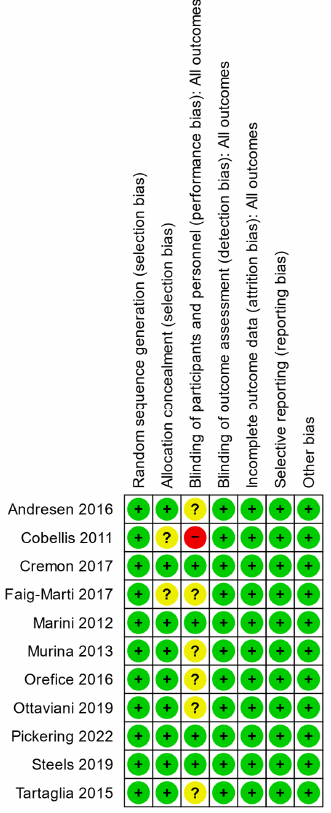
Figure 1. Modified PRISMA flow diagram of study selection.